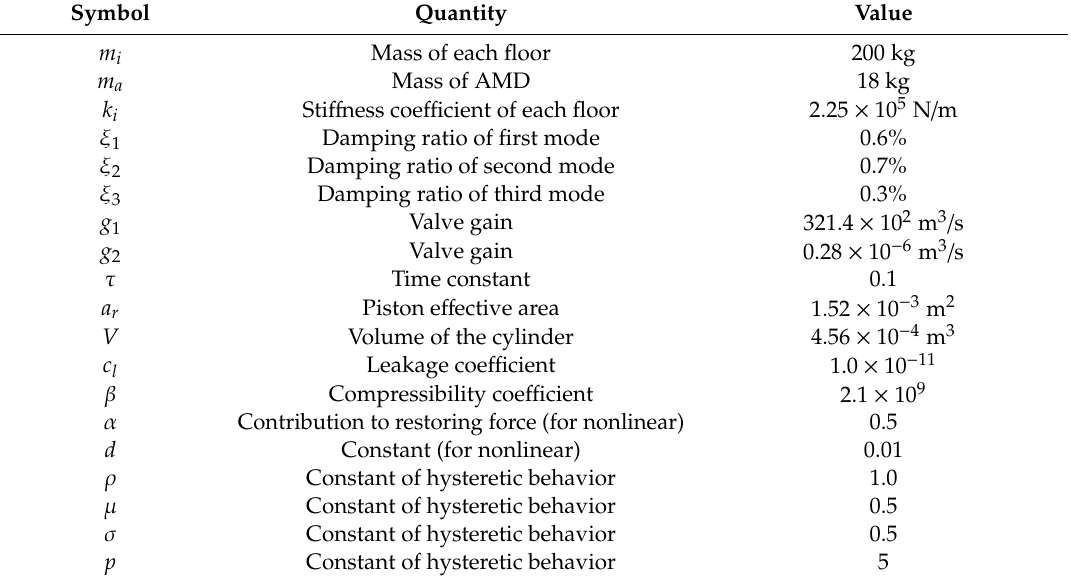
Table 1. Structural model parameters of the AMD device control